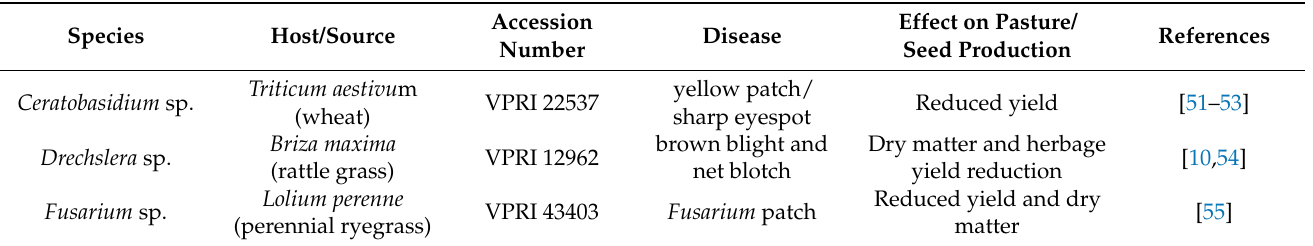
Table 1. Summary of pathogens selected for this study.